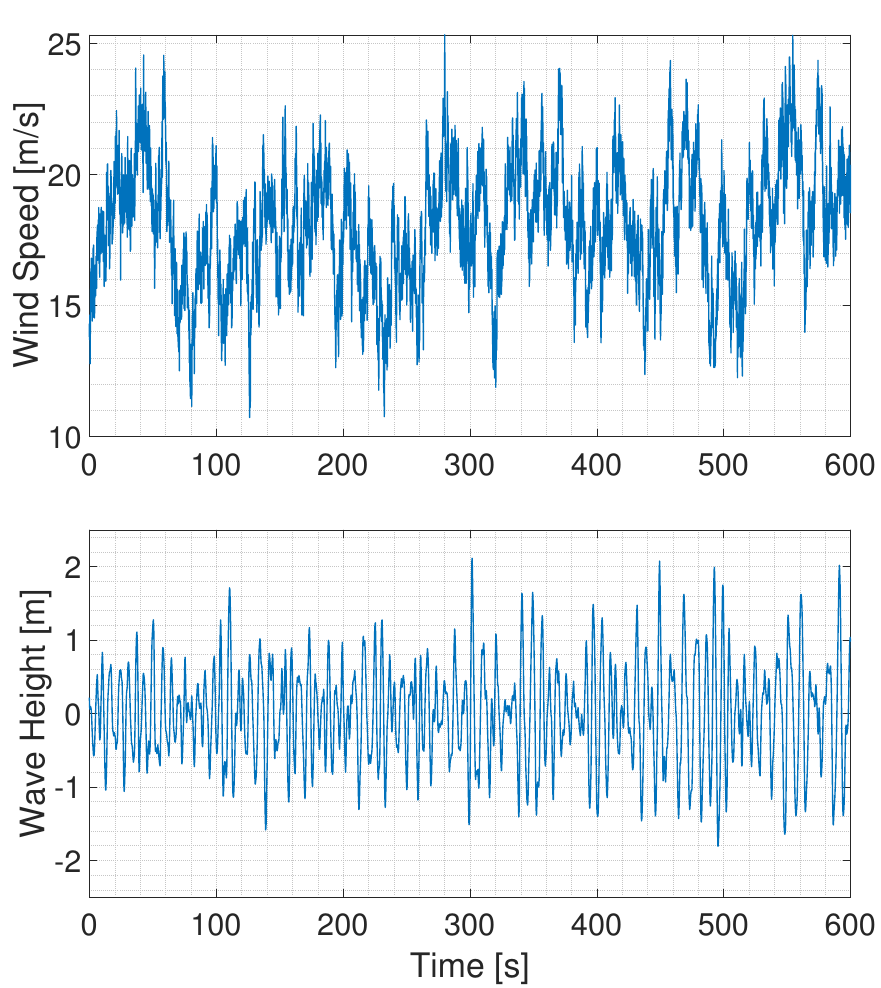
Figure 8. High turbulent wind profile ( top ) and wave height profile ( bottom